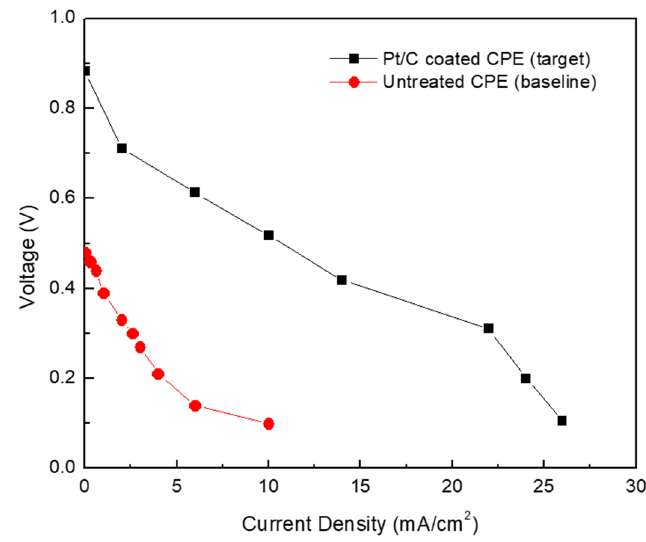
Figure 2. Baseline and target performance of an alkaline alcoholic fuel cell. Baseline performance was obtained from a cell with an untreated cathode carbon porous electrode (CPE), and the target performance was obtained from a cell of a Pt supported on carbon (Pt/C) cathode CPE.